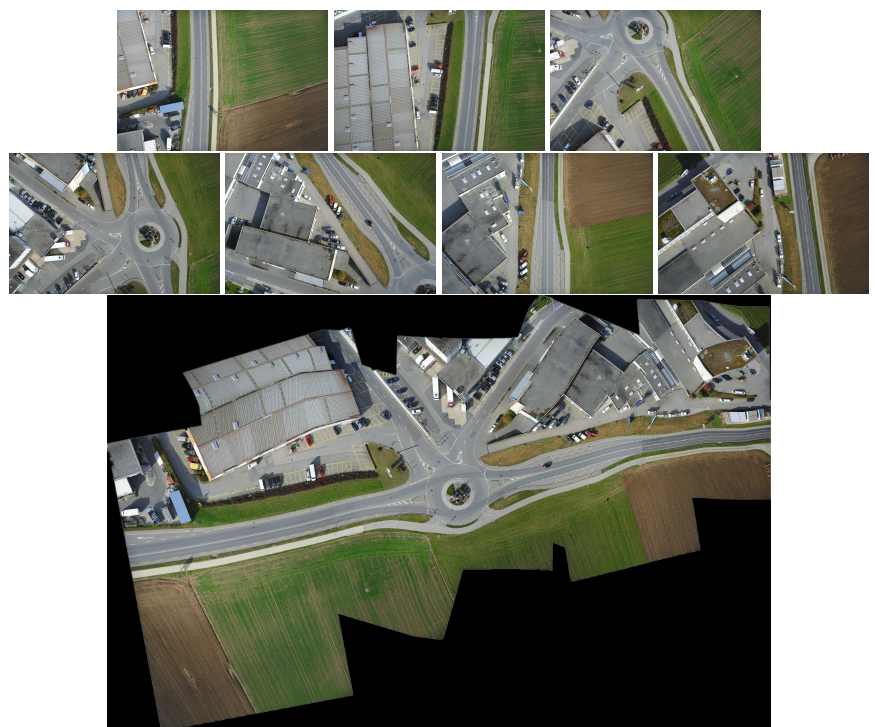
Figure 10. Experimental results of panoramic stitching. The first and second rows are the images to be stitched together. The third row is the result of our method. Autostitch cannot process these images. Our method sacrifices the stiffness of the stitching image. The effect is good when stitching two images. However, distortion is observed in the result when stitching multiple images.